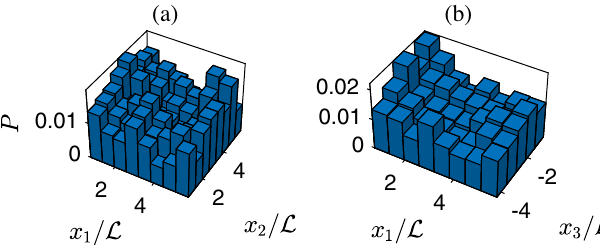
FIG. 10. Probability of the fiber positions from one of the experiments. The x 1 - x 2 plane (a) and x 1 - x 3 plane (b) are, respectively, orthogonal and parallel to the main camera direc- tion. The fiber length is c= L ¼ 0 . 76 , and the turbulence is generated by rough wheels rotating at 400